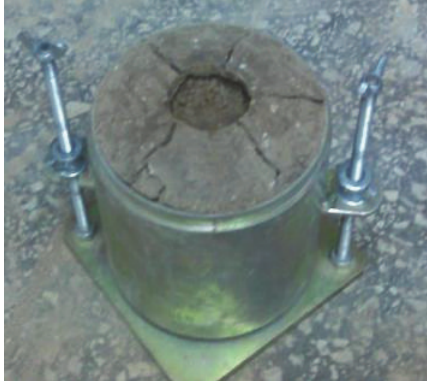
Figure 10: The view of 25% FA mixes sample after the CBR test.